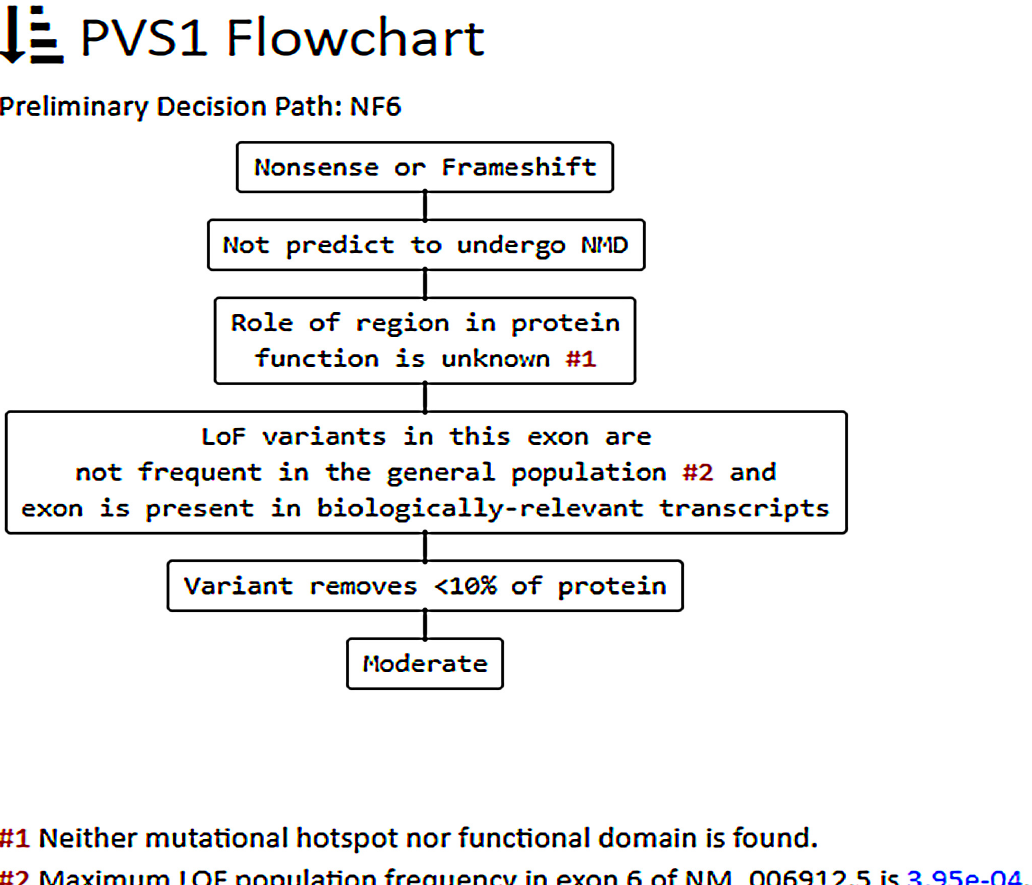
Figure 2. Preliminary decision path for the c.650C>G p.(Ser217*) variant in the RIT1 gene, as calculated by the AutoPVS1 tool